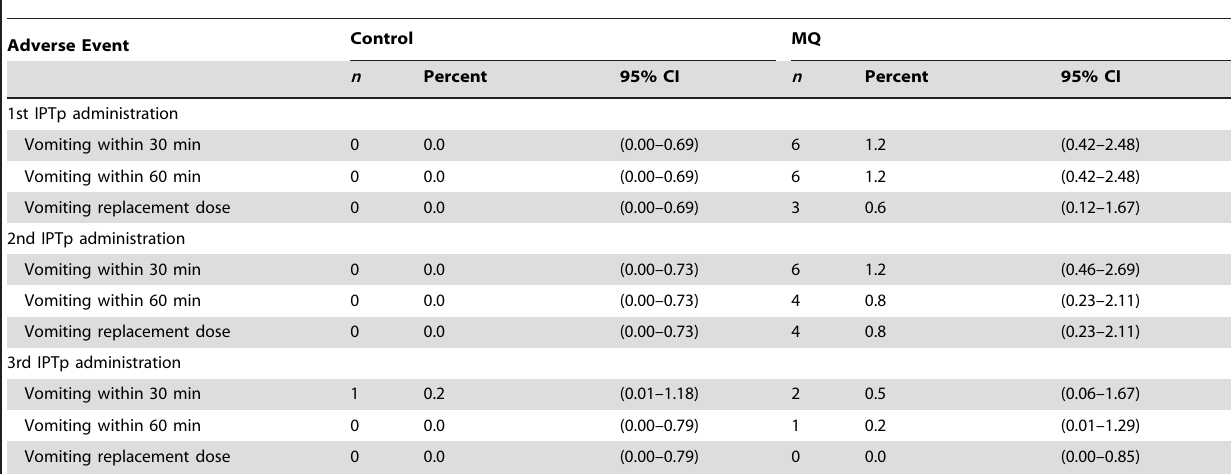
Table 7. Immediate medication tolerability (safety cohort).